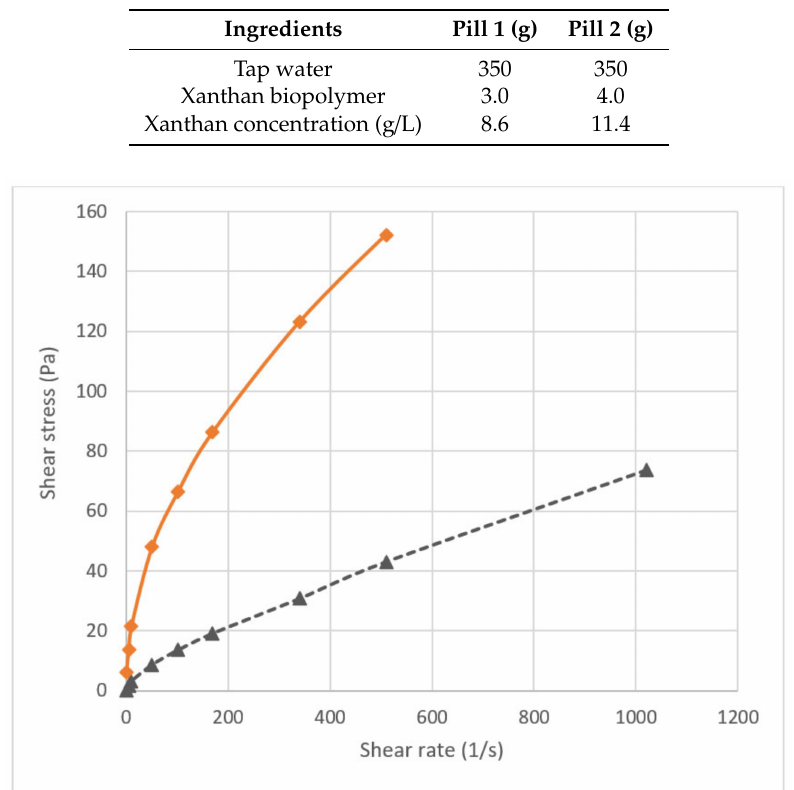
Figure 3. Flow curves of the viscous pills prior to experiments. Stippled line with triangles represents Pill 1 and solid line with diamonds represents Pill